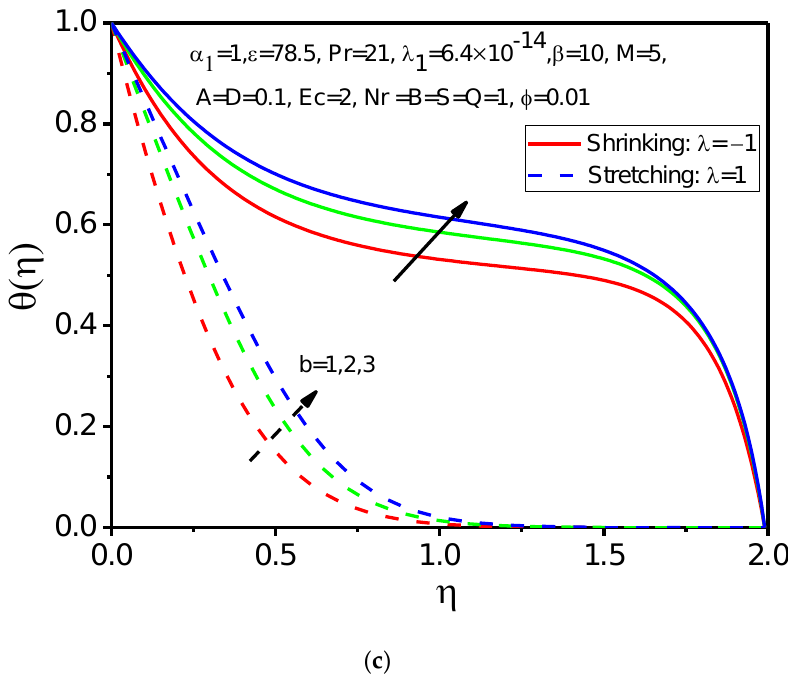
Figure 10. Variation of b on ( a ) Velocity profile, ( b ) Pressure profile, ( c ) Temperature profile.